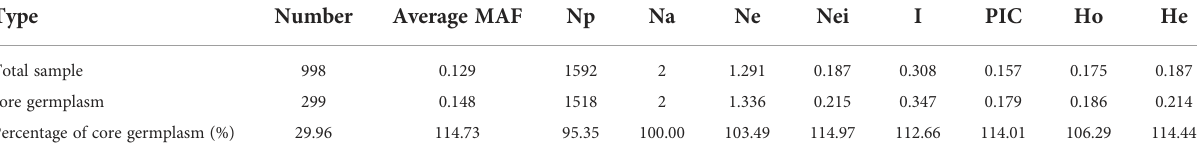
TABLE 3 Genetic diversity parameters between core germplasm and original